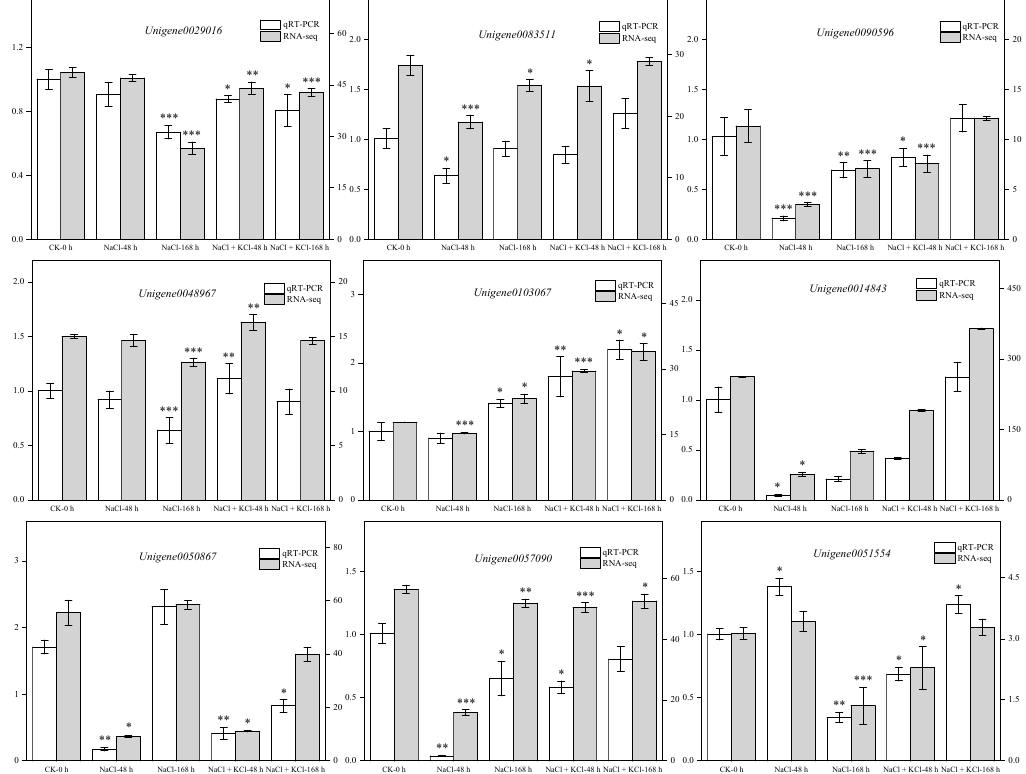
Figure 4. Validation of DEGs by qRT-PCR. (9 DEGs were randomly selected for qRT-PCR validation, and the error bars were obtained from multiple replicates of qRT-PCR. Note: NaCl means 200 mM NaCl treatment group, NaCl + KCl means 200 mM NaCl + 10 mM KCl treatment group). 0.01 < p < 0.05 is marked as *; 0.001 < p < 0.01 is marked as **; p ≤ 0.001 is marked as